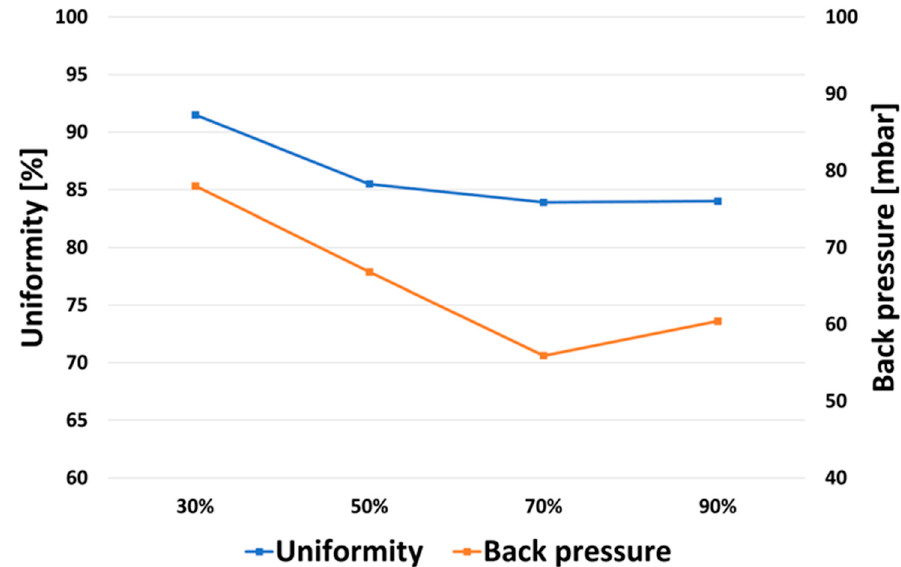
Figure 12. Correlation between uniformity, back pressure, and filter porosity.